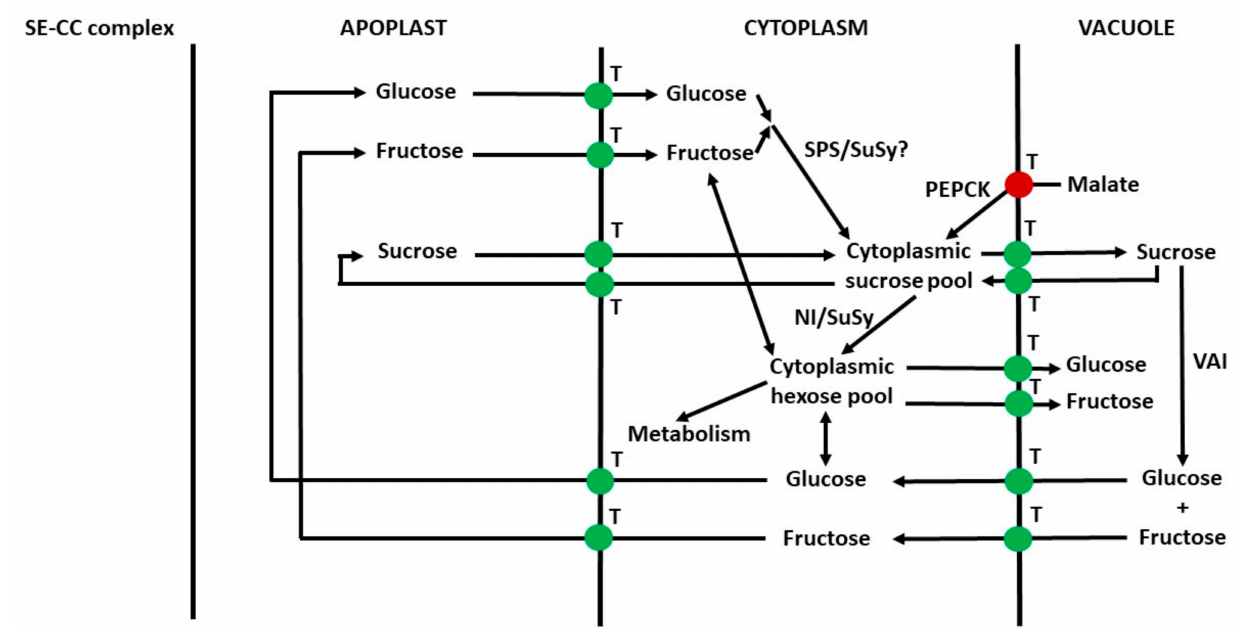
Figure 2. The sucrose cycle consists of the breakdown and resynthesis of sucrose from its breakdown products. Sucrose has a pivotal role in cell metabolism; it can be imported, exported, accumulated, broken down and resynthesised in different cell compartments. This allows a multifaced control of sugars concentrations and fluxes in the cell compart- ments, thereby modulating the various sugar functions in a complex metabolic network. Abbreviations: NI = neutral invertase; PEPCK = phosphoenolpyruvate carboxykinase; SE-CC = sieve element-companion cell; SuSy = sucrose synthase; SPS = sucrose phosphate synthase, T (green circle) = sugar transporter; T (red circle) = malate transporter; VAI = vacuolar acid